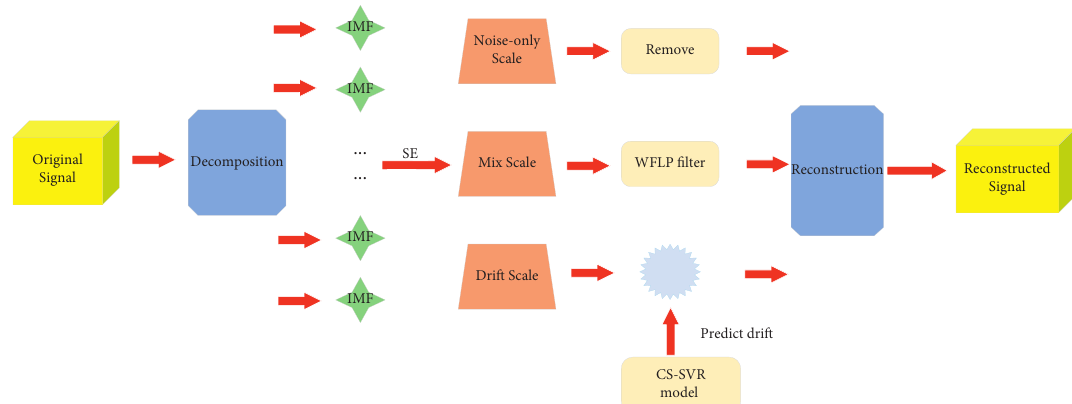
Figure 2: Variational modal decomposition